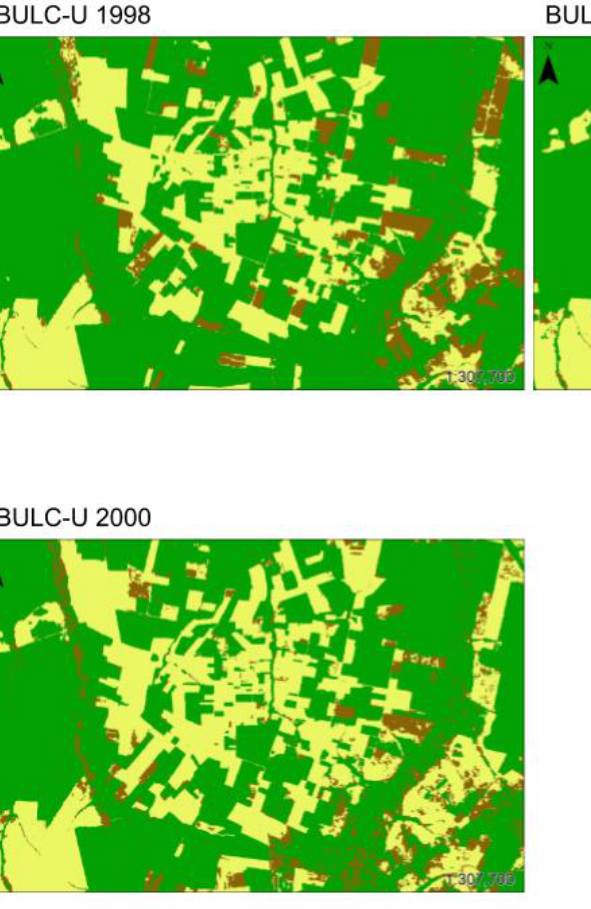
Figure 10. Land cover in Querência during 1996 – 2000, encompassing the second period of rapid deforestation expansion at the expense of forest.